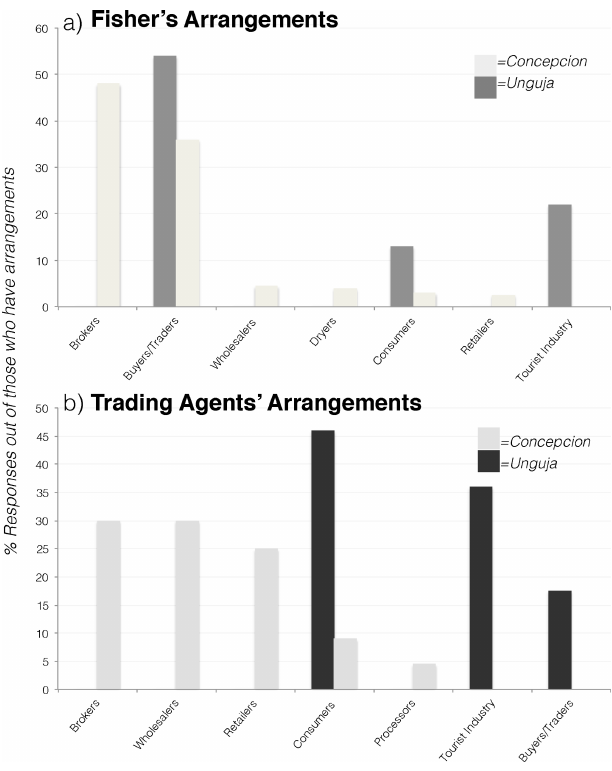
Fig. 5 . Bar charts showing the frequency of sales arrangements between (a) fishers and their buyers, and (b) traders and their buyers in Unguja (darker grey) and Concepcion (lighter grey). Percentages indicate the proportion of arrangements with each type of node (x-axis). The bars represent the % frequency of interview respondents’